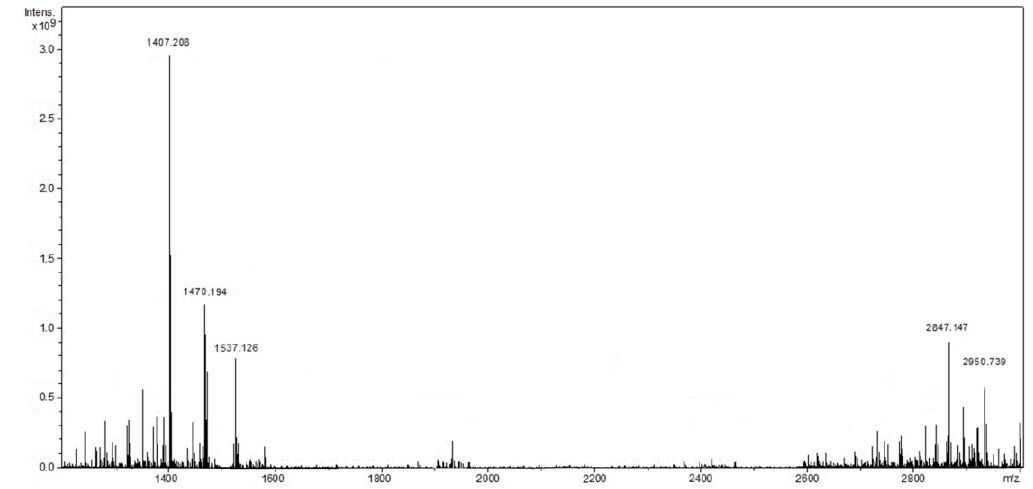
Figure 4. Mass spectrum of the I-Cu-I .